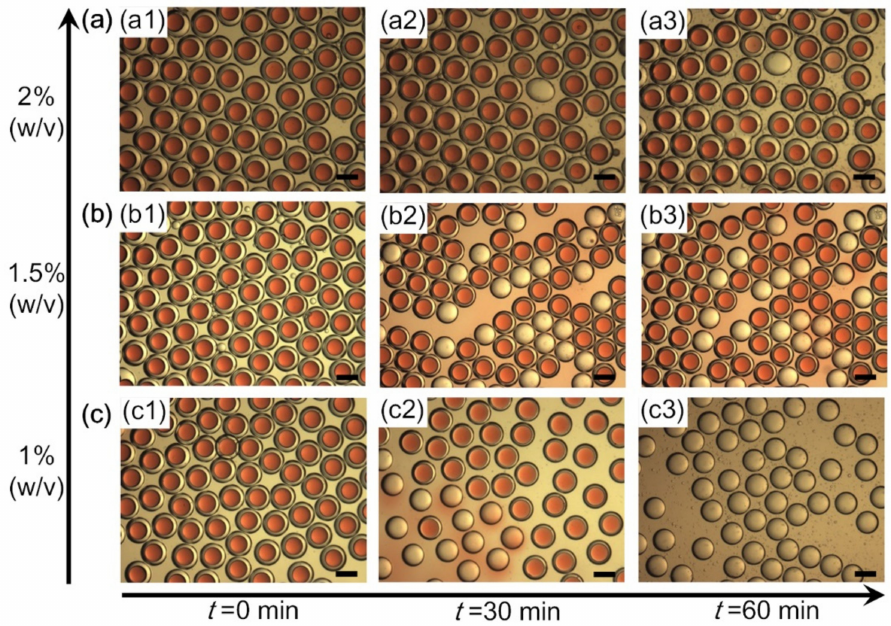
Figure 5. The influence of GDL content on the gelling process. The concentrations of alginate sodium and EDTA-Ca in the middle aqueous layer of O/W/O emulsions are fixed at 2% ( w / v ) and 0.1 M, respectively, while that of the GDL is varied from 2% ( w / v ) to 1% ( w / v ) ( a – c ). Scale bars are 200 µ m. As the GDL is premixed with alginate sodium and the EDTA-Ca contained aqueous solution as the middle fluid, the hydrolysis of GDL and gelling reaction will start during the formation of O/W/O emulsions in the microfluidic device. After about 50 min of premixing of GDL, the formation of O/W/O emulsions in the microfluidic device become unstable and, at the same time, the microfluidic device also takes the risk of blocking of hydrogel. With the further increase of the content of GDL to 3% ( w / v ), alginate microcapsules could also be produced (as shown in Figure S6). However, the duration of O/W/O emulsions formed stably in the microfluidic device will